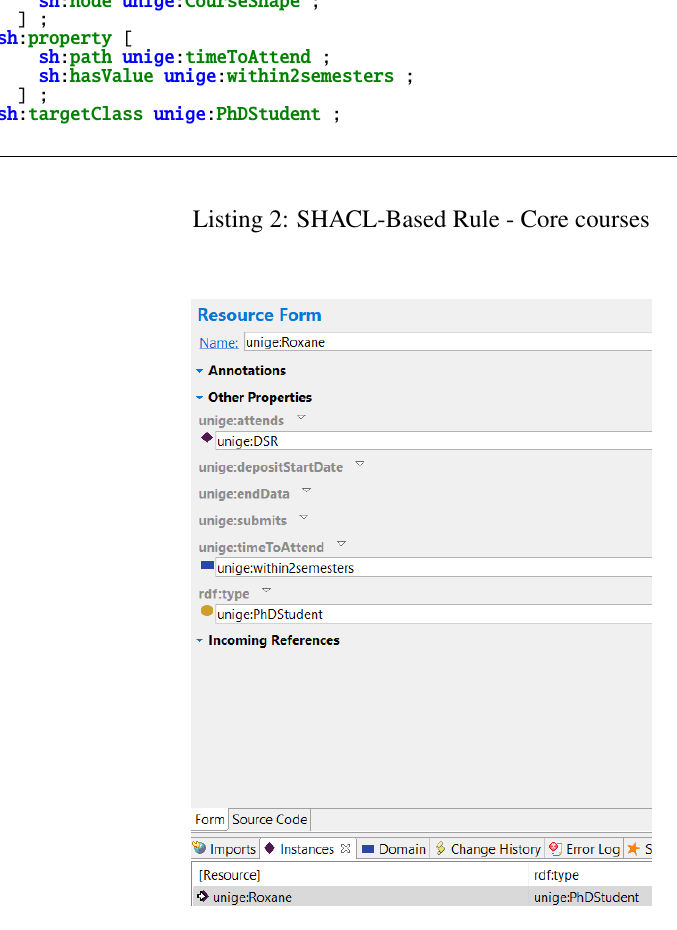
Figure 7: The instantiation of SHACL-based Rule Core Course (pass validation)